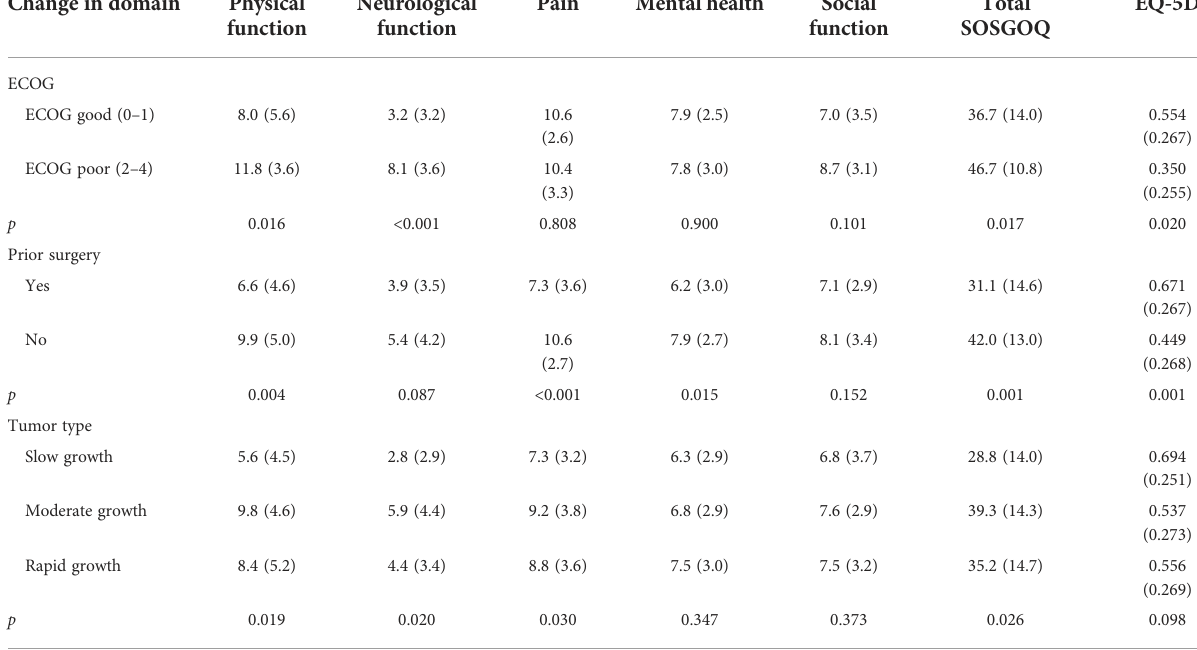
TABLE 5 Sensitivity to changes in the SOSGOQ based on changes in ECOG score.